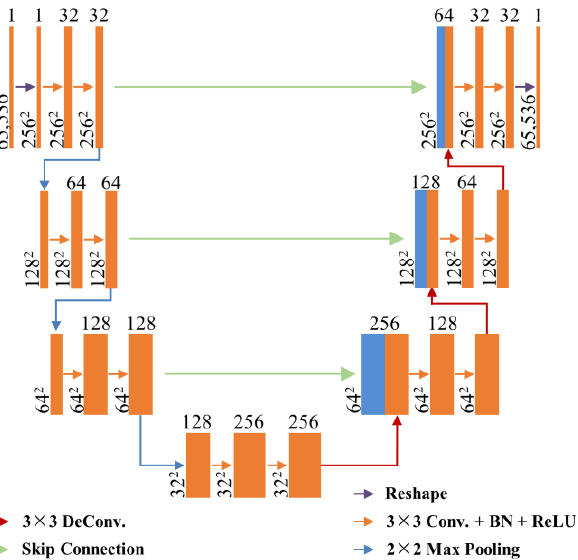
Figure 2. The structure of the proposed network, where the numbers in each layer indicate the shape of its output. Conv, convolution layer; DeConv, deconvolution layer; BN, batch normalization; ReLU, rectified linear unit.